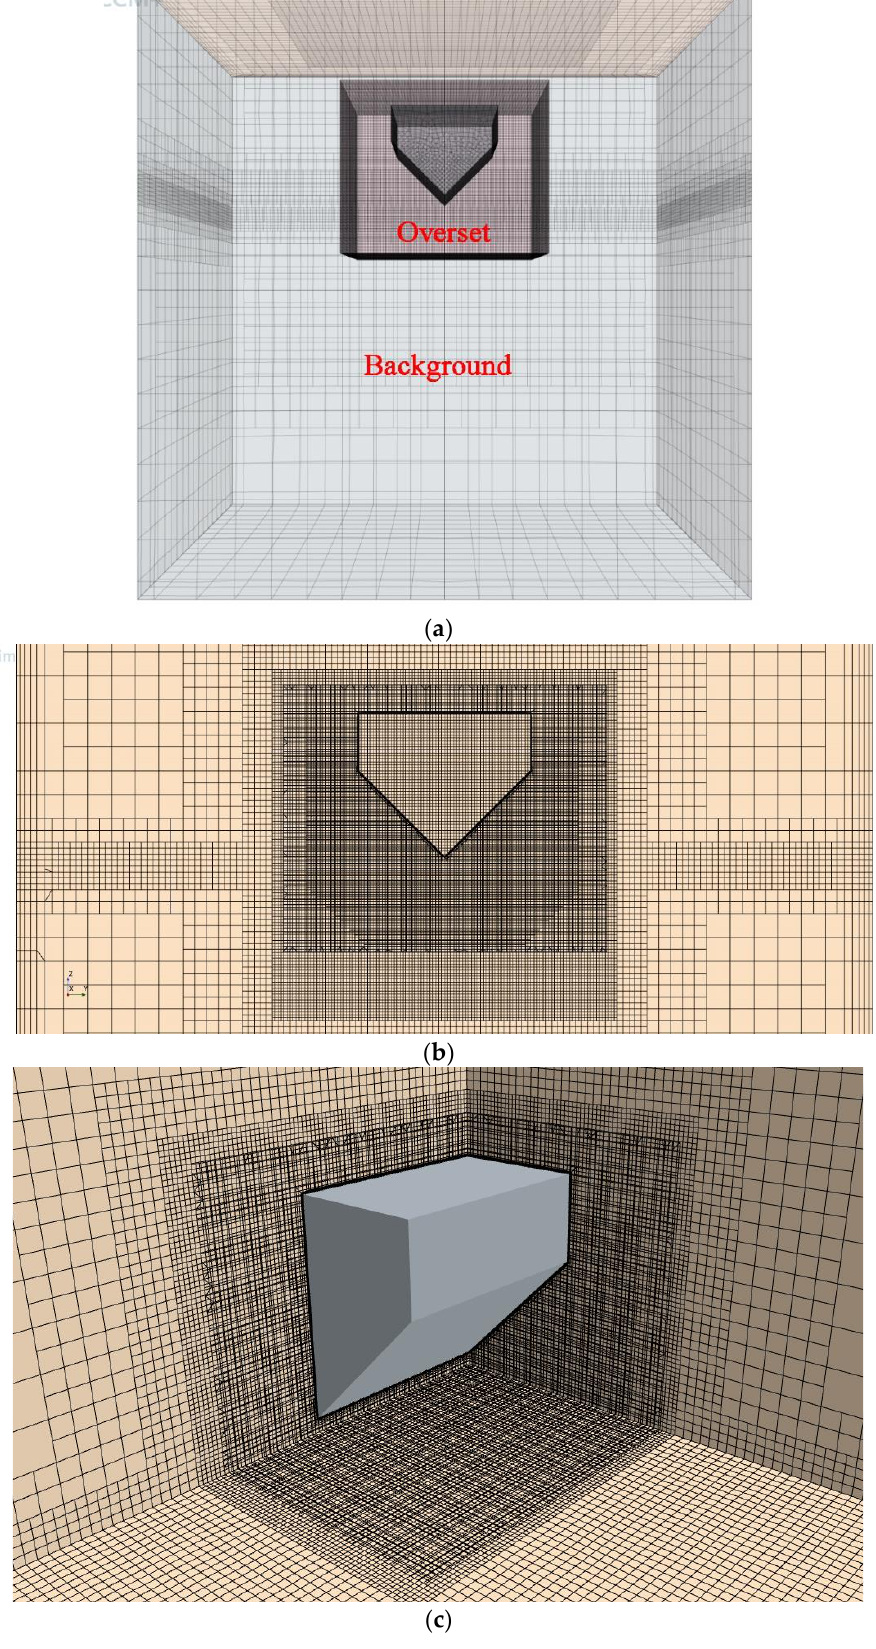
Figure 6. Mesh generation of fluid domain: ( a ) overview of background and overset regions; ( b ) mesh at middle cross-section; ( c ) local mesh refinement around the wedge.